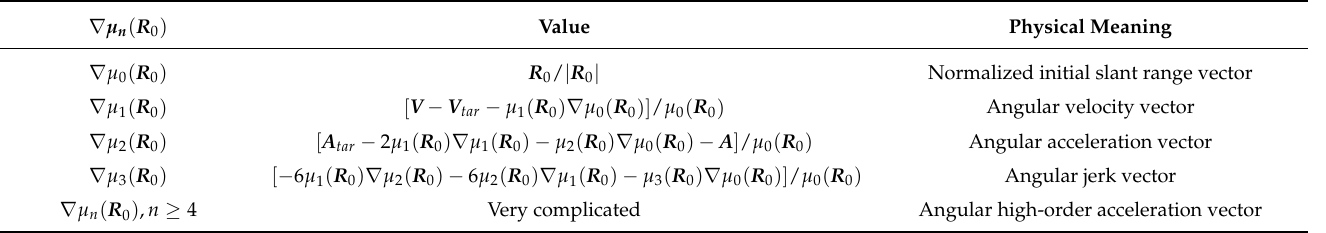
Table 2. Values and physical meanings for ∇ µ n ( R 0 ) .